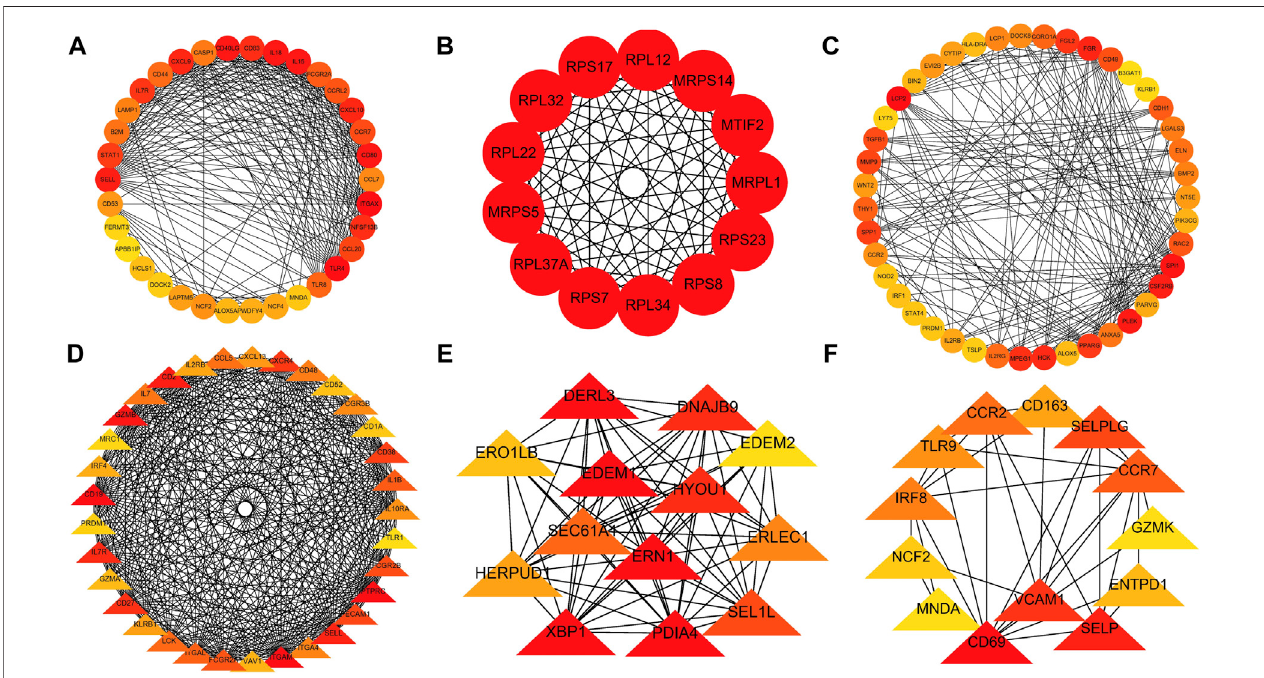
FIGURE 3 | The PPI network. (A – C) The clusters 1-3 extracted from green module in NAFLD. (D – F) The clusters 1-3 extracted from the cyan module in periodontitis. PPI, protein – protein network; NAFLD, nonalcoholic fatty liver disease.